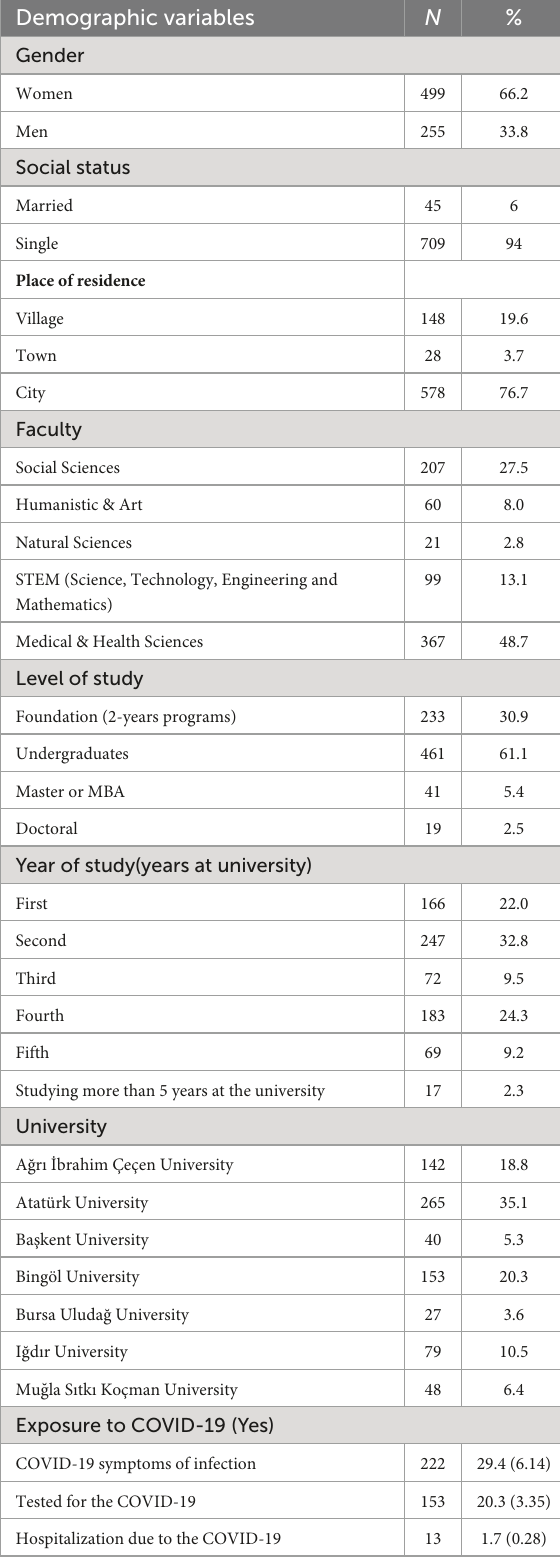
TABLE 1 Demographic characteristics of the study sample and COVID-related and psychological variables ( n = 754). Demographic